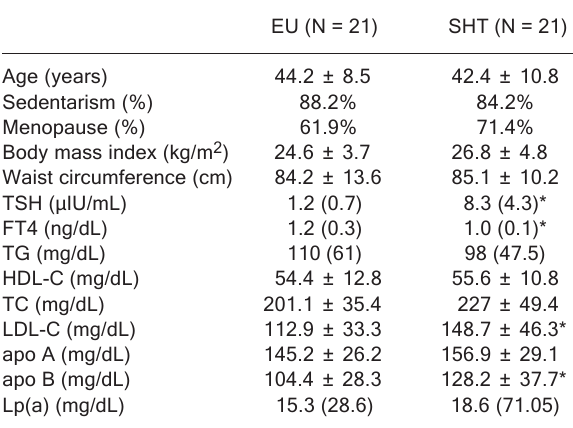
Figure 2. The greatest distance between the lumen-intima inter- face and the media-adventitia interface to calculate intima-media thickness of the carotid artery (a). Table 1. Clinical and laboratory characteristics of the women with subclinical